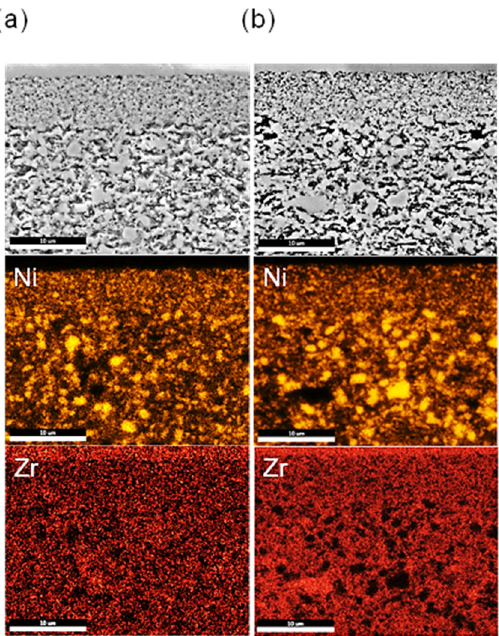
Figure 10. SEM-EDX mapping of single cells towards the fuel electrode side for Ni (K α , 7.47 keV), Zr (L α , 1.81 keV) line ( a ) before and ( b ) after the long-term test up to 1000 h at 800 °C with 50% H 2 + 50% H 2 O.